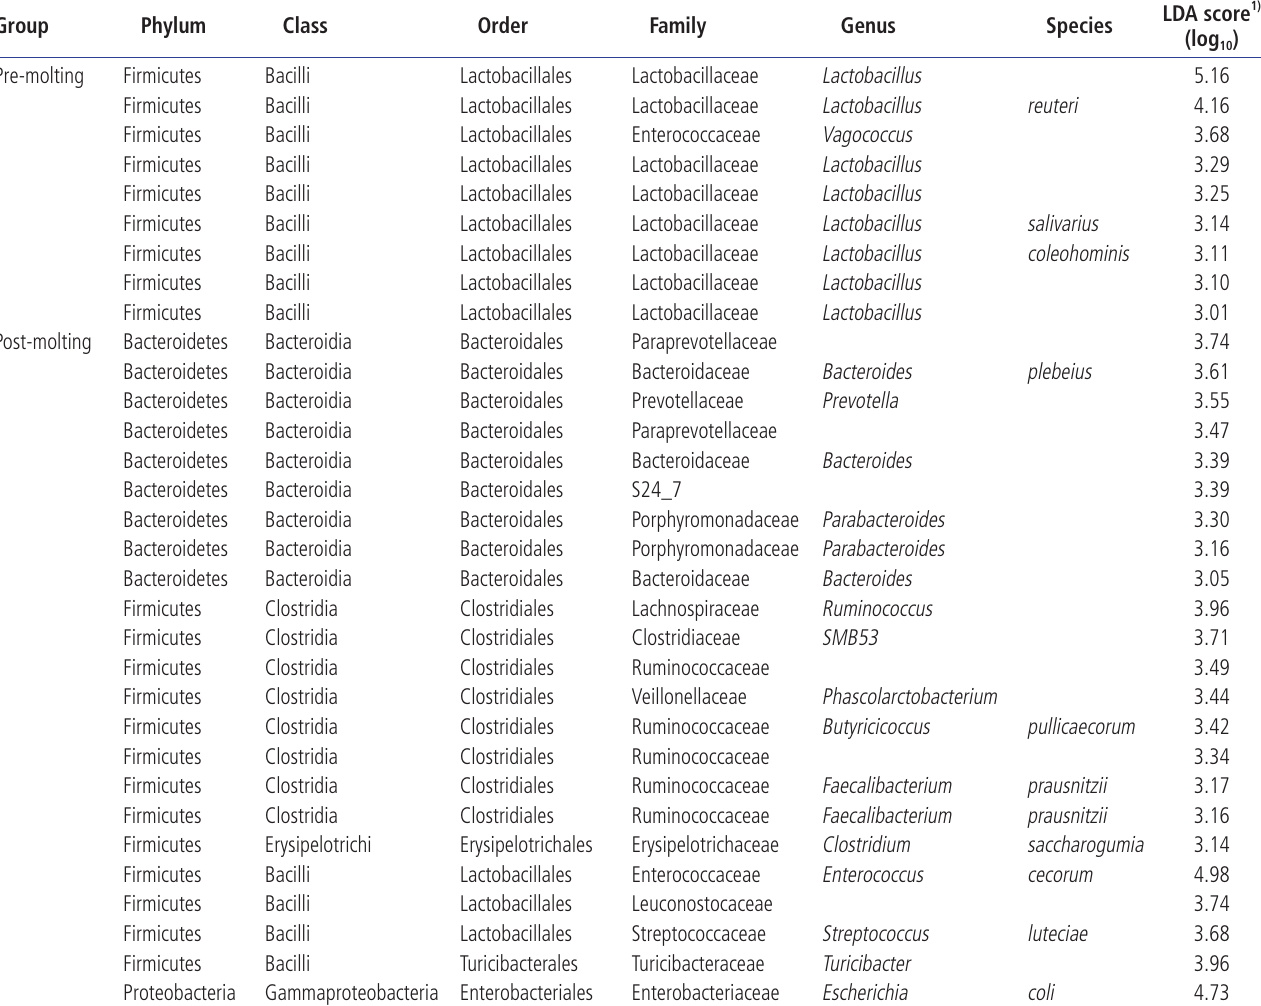
Table 2. Excreta bacterial community differences between pre-molting and immediate post-molting hens using linear discriminant analysis effect size (LEfSe)